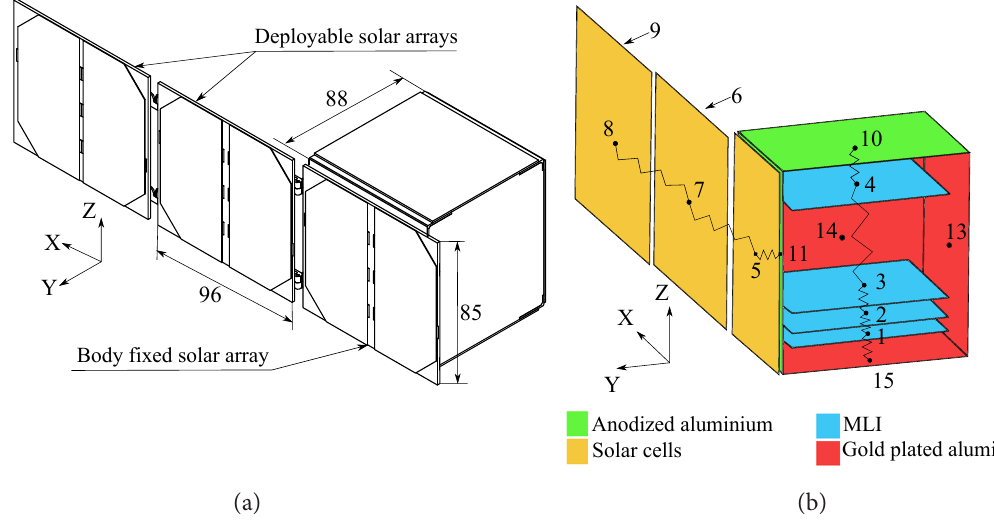
Figure 3. Spacecraft geometry (a) and thermal model (b). Jagged lines in (b) show linear conductors between thermal nodes. Back surfaces of deployable solar arrays (nodes 6 and 9) are covered with